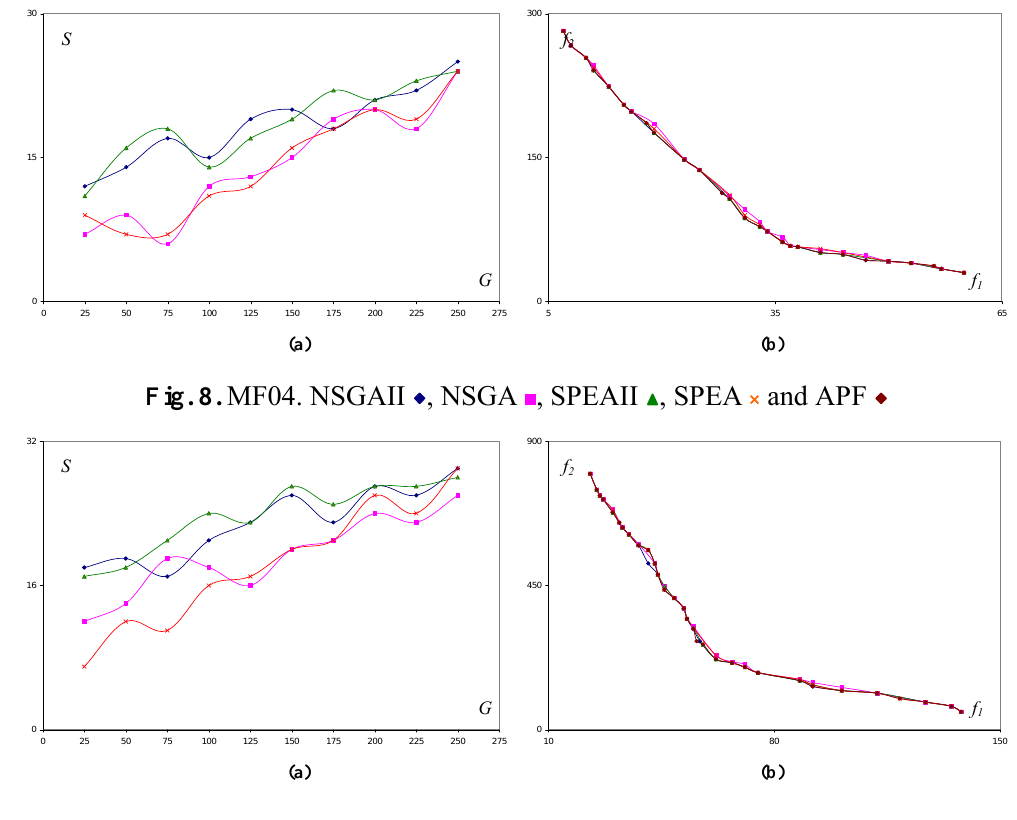
Fig. 9. MF05. NSGAII , NSGA , SPEAII , SPEA and APF